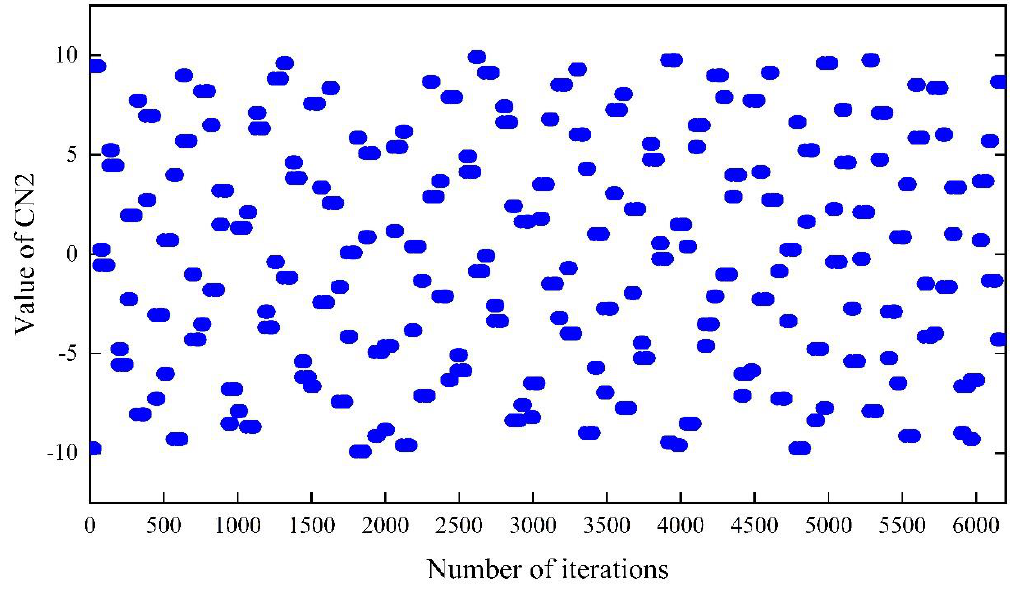
Figure 6. Schematic diagram of parameter sampling of Sobol sequence method, taking CN2 as an example.